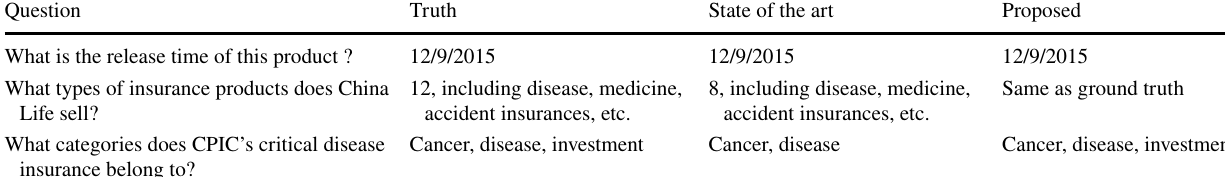
Table 1 QA cases of the current and proposed approaches Question Truth